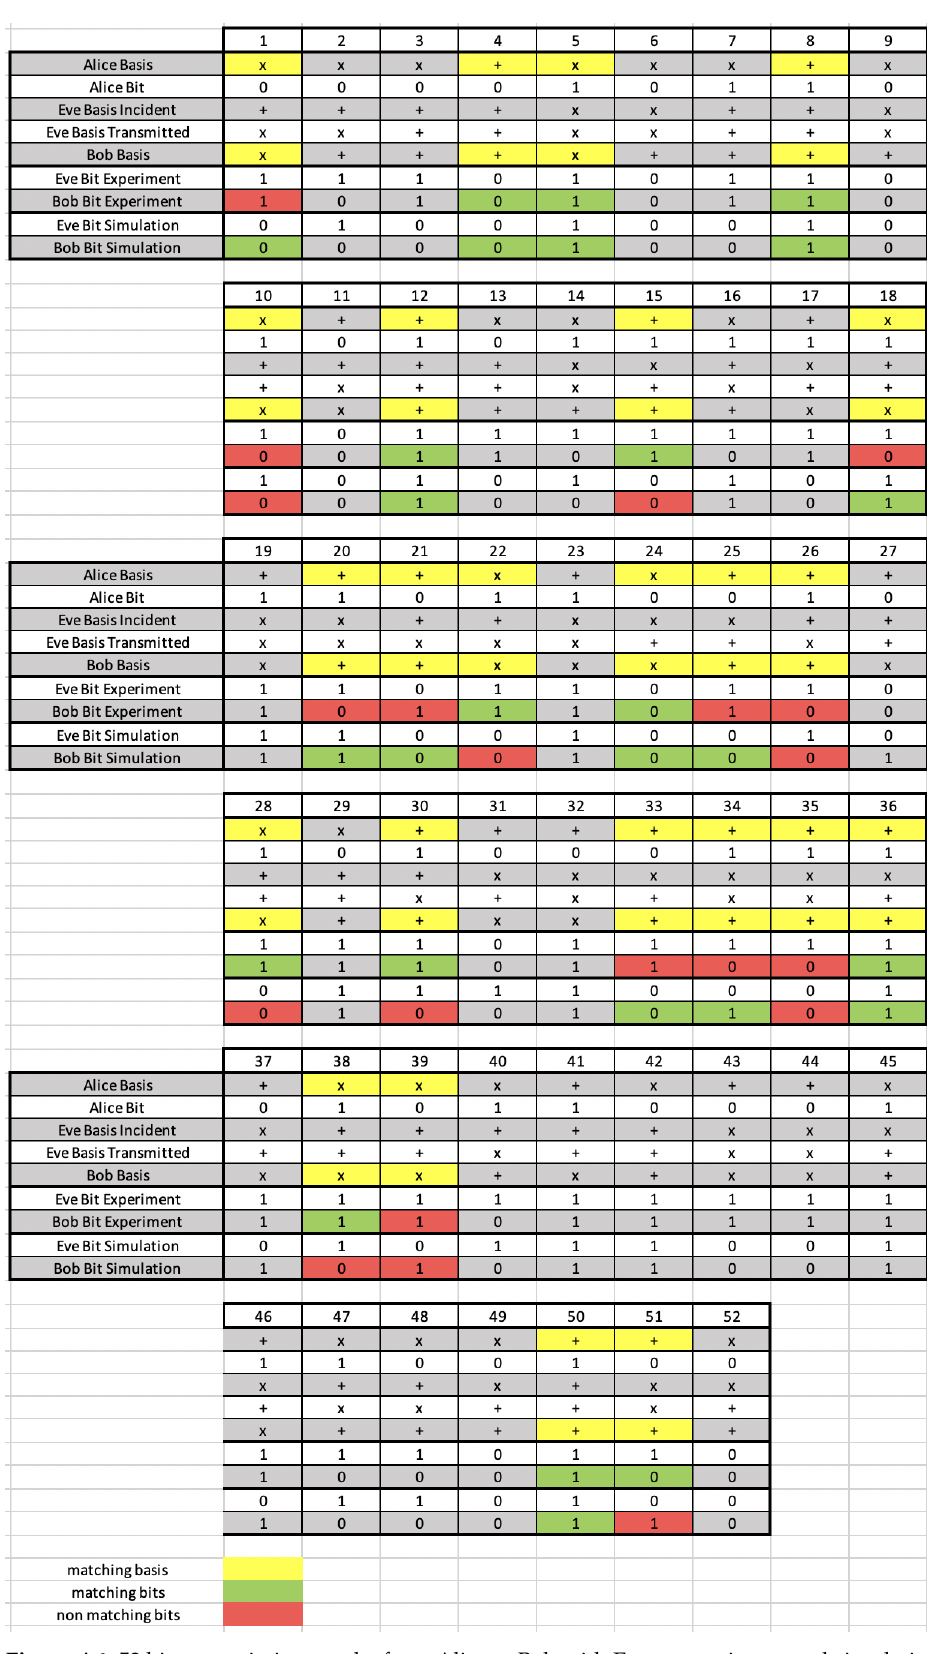
Figure A6. 52 bit transmission results from Alice to Bob with Eve—experiment and